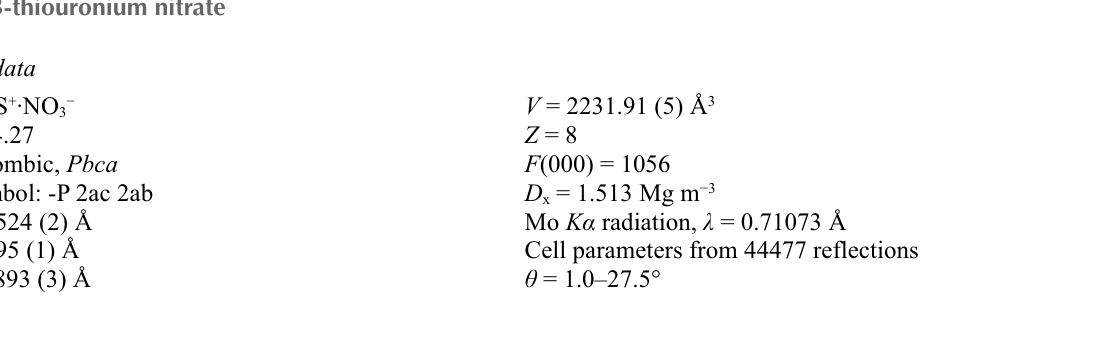
sup-3 Acta Cryst. (2008). E 64 , o194